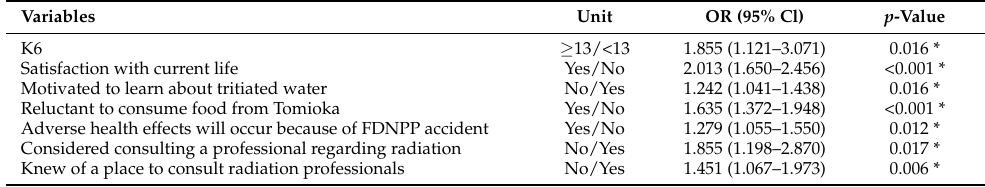
Table 2. Factors independently associated with evacuees compared to returnees among Tomioka